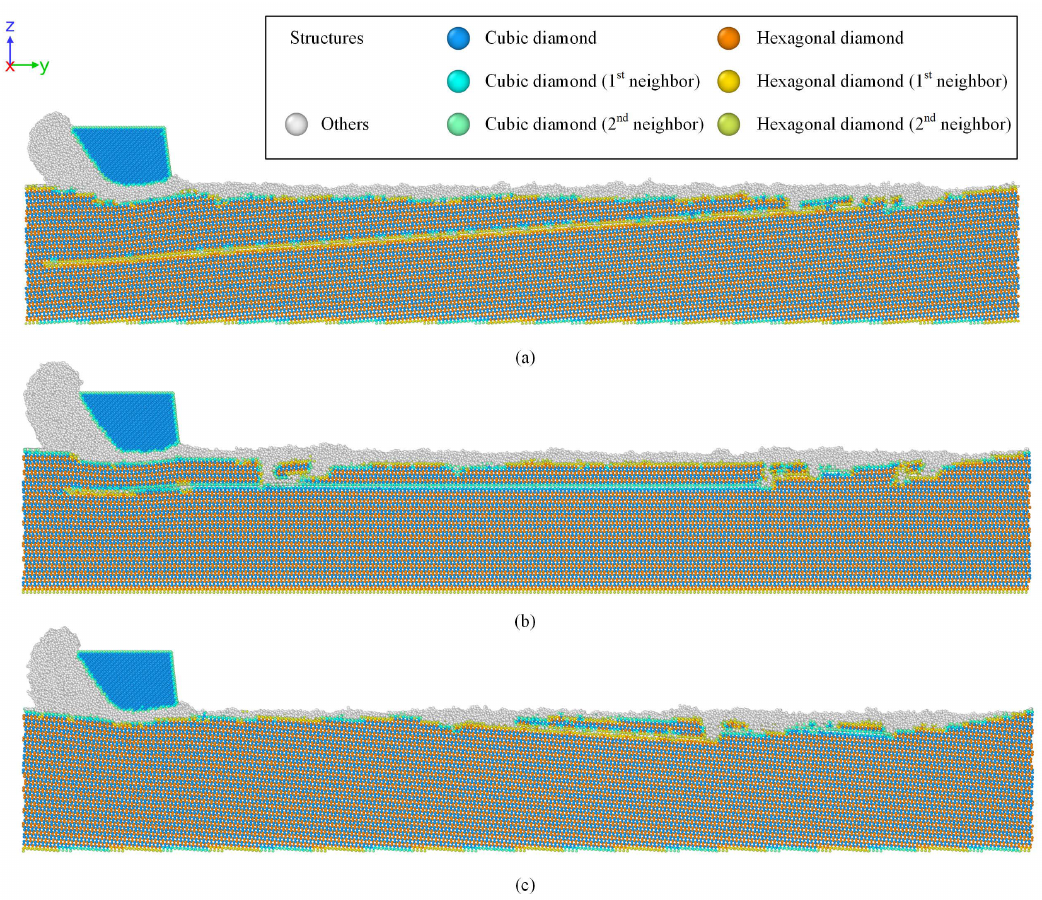
Figure 4. Structure transformation of three workpiece models after cutting: ( a ) 4 ◦ off-axis toward [1 − 100]; ( b ) on-axis; ( c ) 4 ◦ off-axis toward [ − 1100].